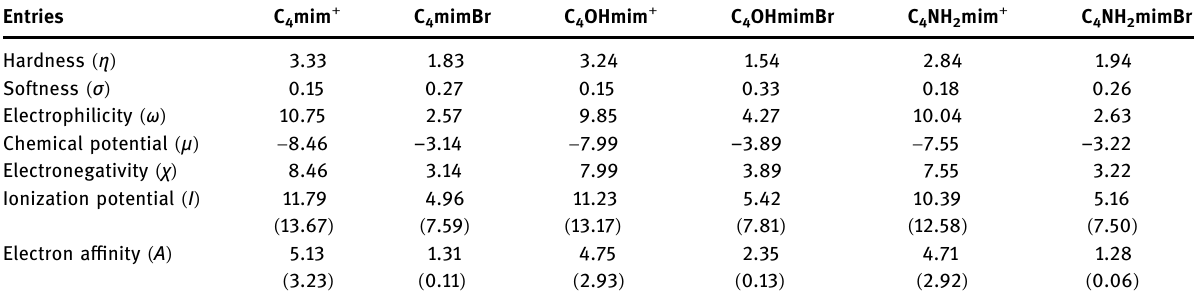
Table 5: Chemical reactivity descriptors ( unit: eV )